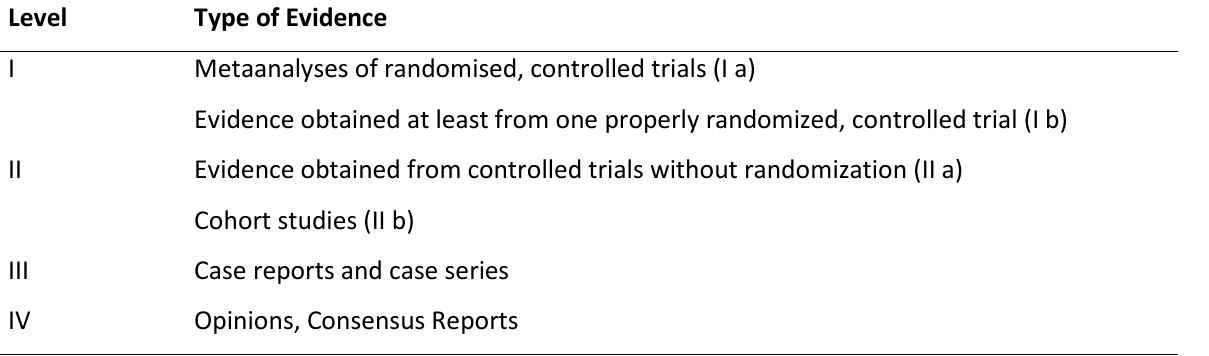
Table 1: Levels of